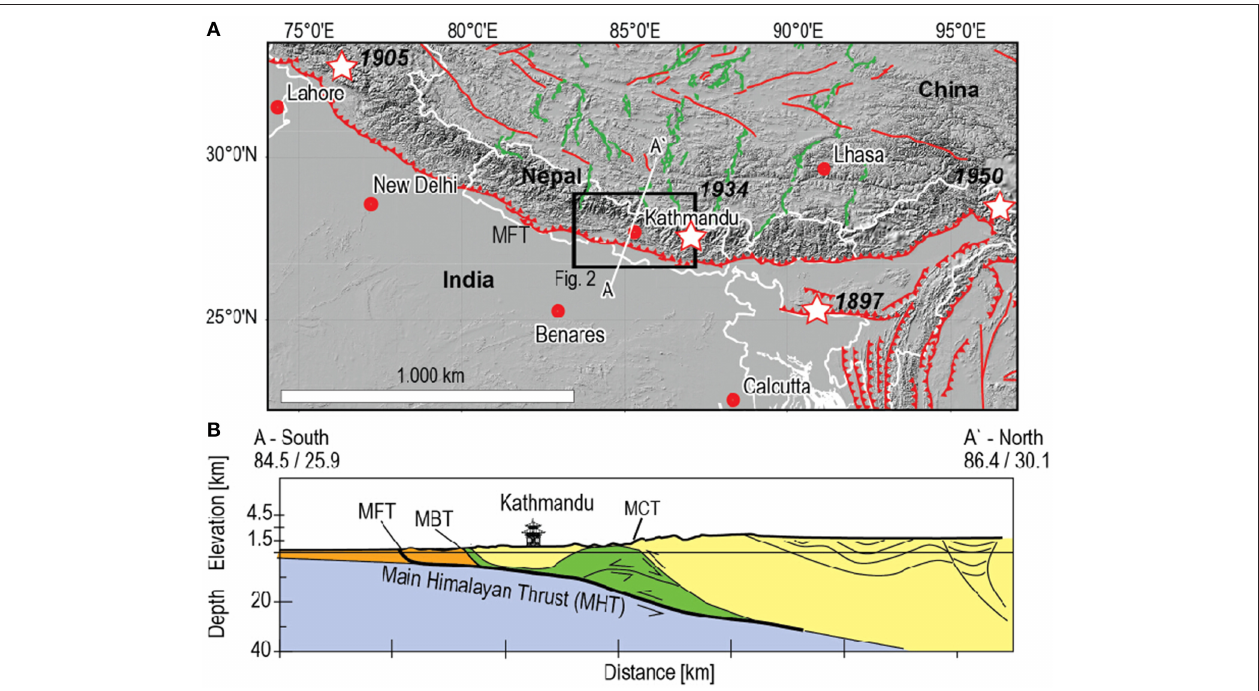
FIGURE 1 | (A) Geodynamic map of Nepal and surrounding, SRTM topography derived shaded relief map, fault lines after the Himalaya Tibet Map (Styron et al., 2010 ). Open stars: great Himalayan earthquakes since 1895. Solid lines: Main Frontal Thrust (MFT) and other thrusts in red, normal faults in green, country borders in white. The black box shows the area of Figure 2 . (B) Cross section with the main tectonic faults, depicting the thin skinned nappe structure of the Kathmandu region after ( Avouac et al., 2001). MFT, Main Frontal Thrust; MBT, Main Boundary Thrust; MCT, Main Central Thrust. The Main Himalayan Thrust—MHT connects these faults at depth at a localized detachment plane. This figure is drawn using GMT